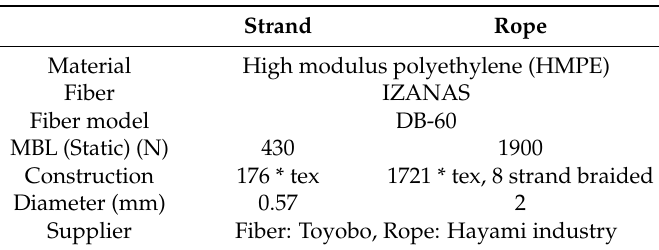
Figure 1. Braided HMPE rope composed of eight strands. Table 1. Properties of braided HMPE strand and